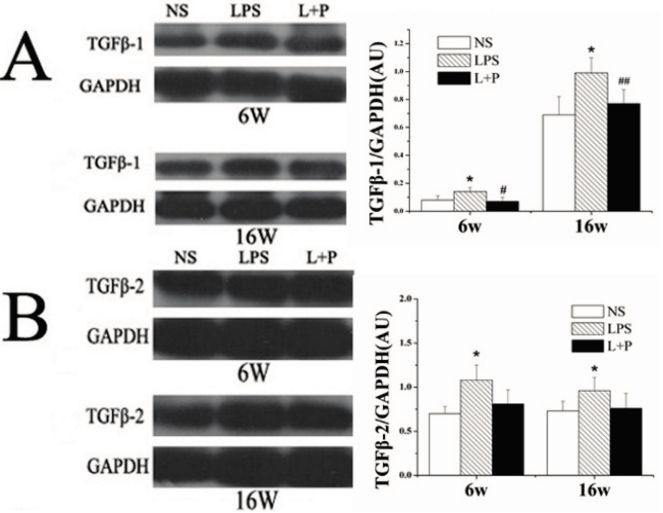
Figure 4. Effects of prenatal exposure to LPS or LPS + PDTC on the expression of TGF β -1 ( A ) and TGF β -2 ( B ) in heart tissue from six- and 16-week-old rat offspring. The values are presented as the means ± SD. * p < 0.05 compared with the NS group; # p < 0.05, ## p < 0.01 compared with the LPS